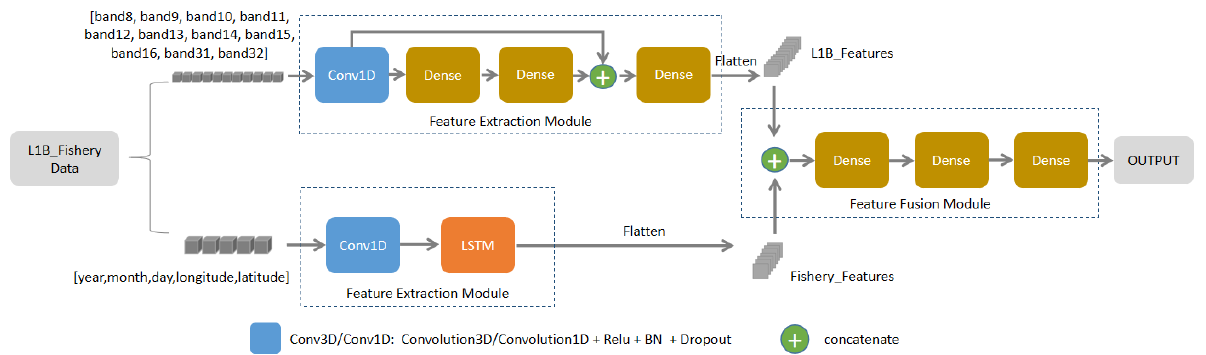
Figure 8. The heterogeneous data feature ‐ extraction model’s structure with L1B_Fishery data as in ‐ put.